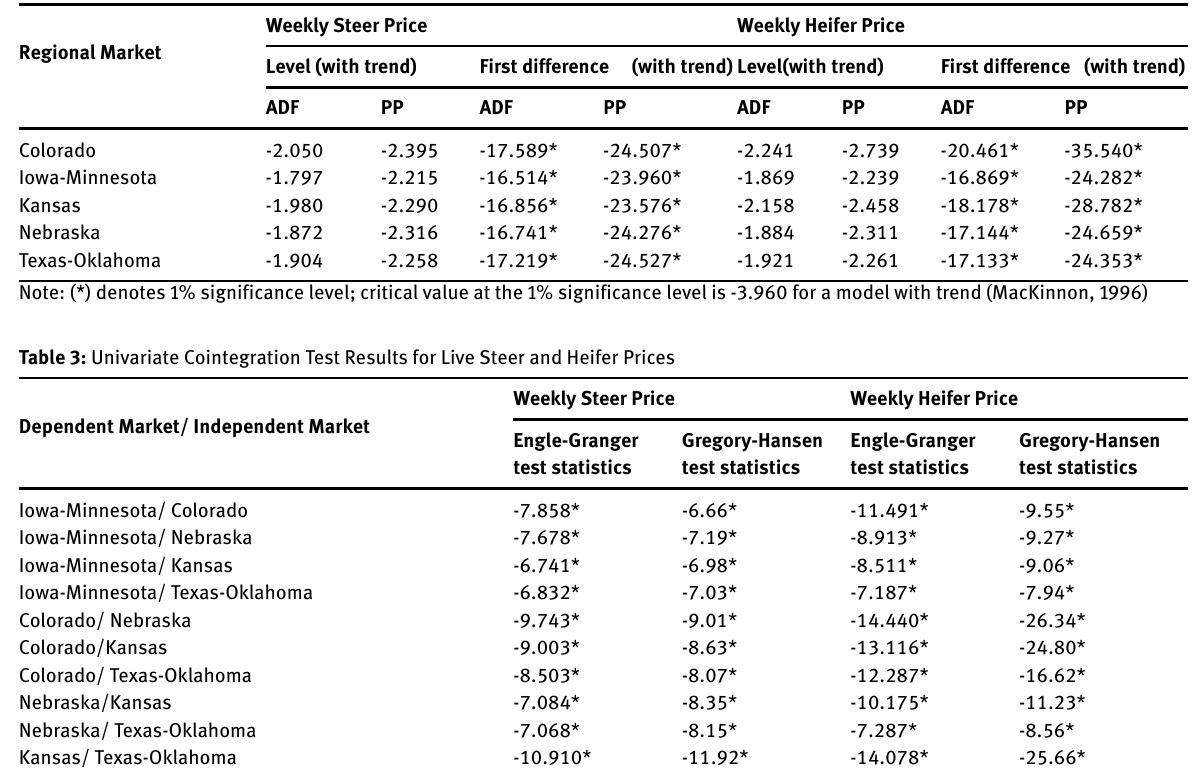
Table 2: Augmented Dickey Fuller and Phillips-Perron Unit Root Test for Live Steer and Heifer Price Series